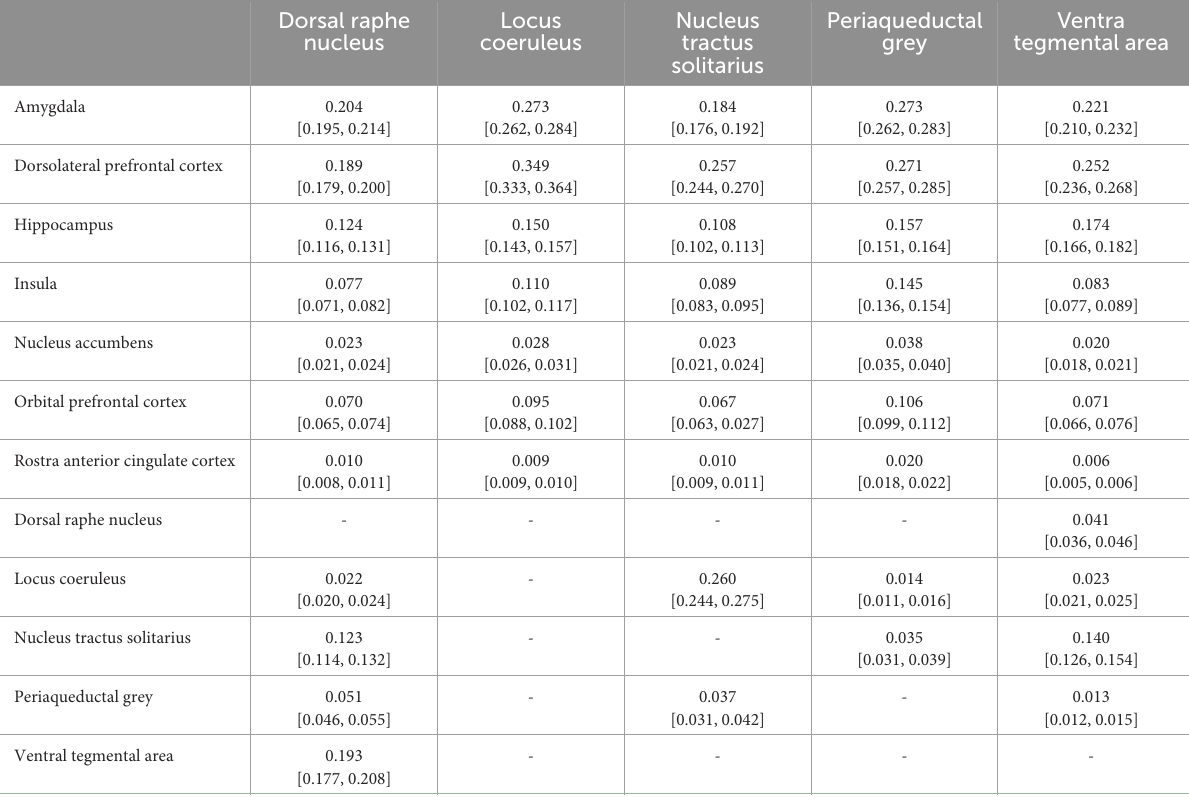
TABLE 3 Average probabilities of connectivity; format: Mean [95% CI interval]. Dorsal raphe